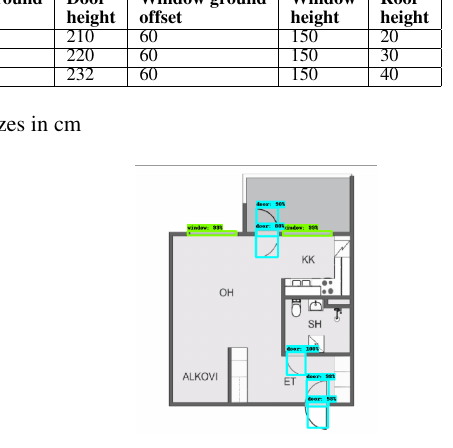
Figure 2. Floor plan outline Figure 3. Object Detection